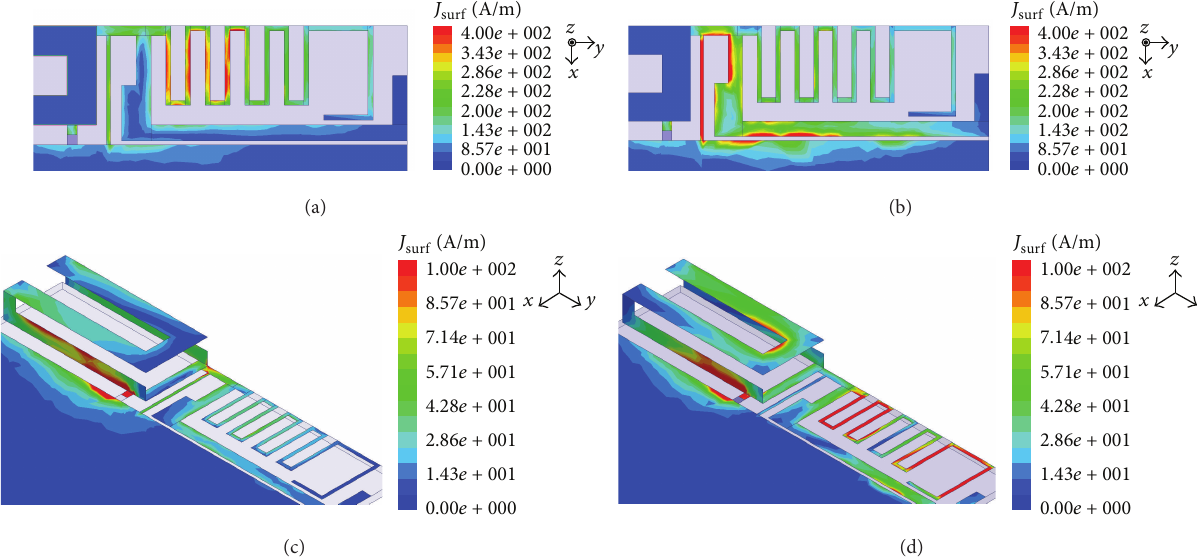
Figure 7: Simulated surface current distributions of the proposed antenna. (a) First resonance at low band (850 MHz). (b) Second resonance at low band (930 MHz). (c) First resonance at high band (1810 MHz). (d) Second resonance at high band (2640 MHz).